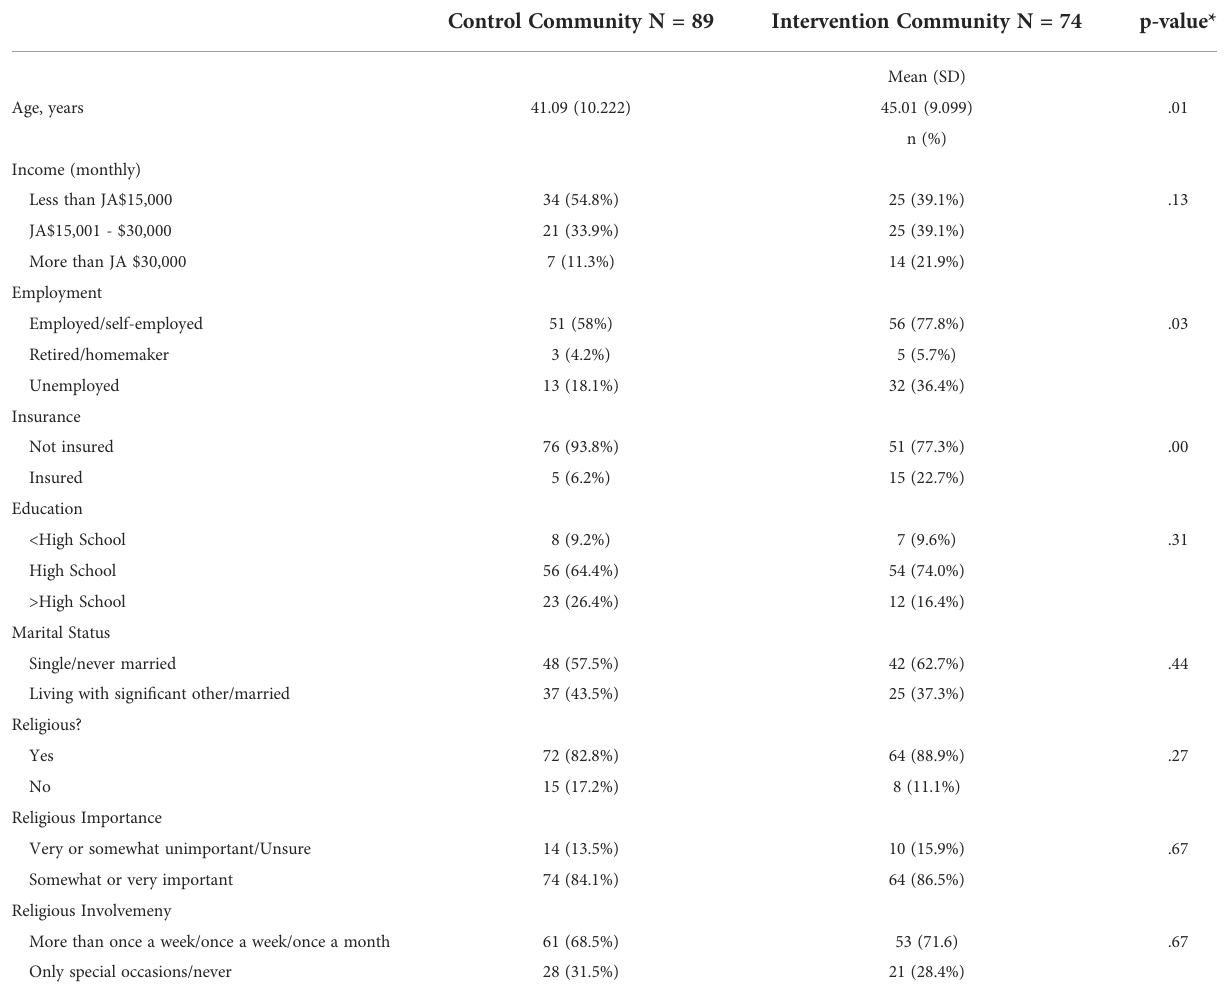
TABLE 1 Participant socio-demographic characteristics by intervention